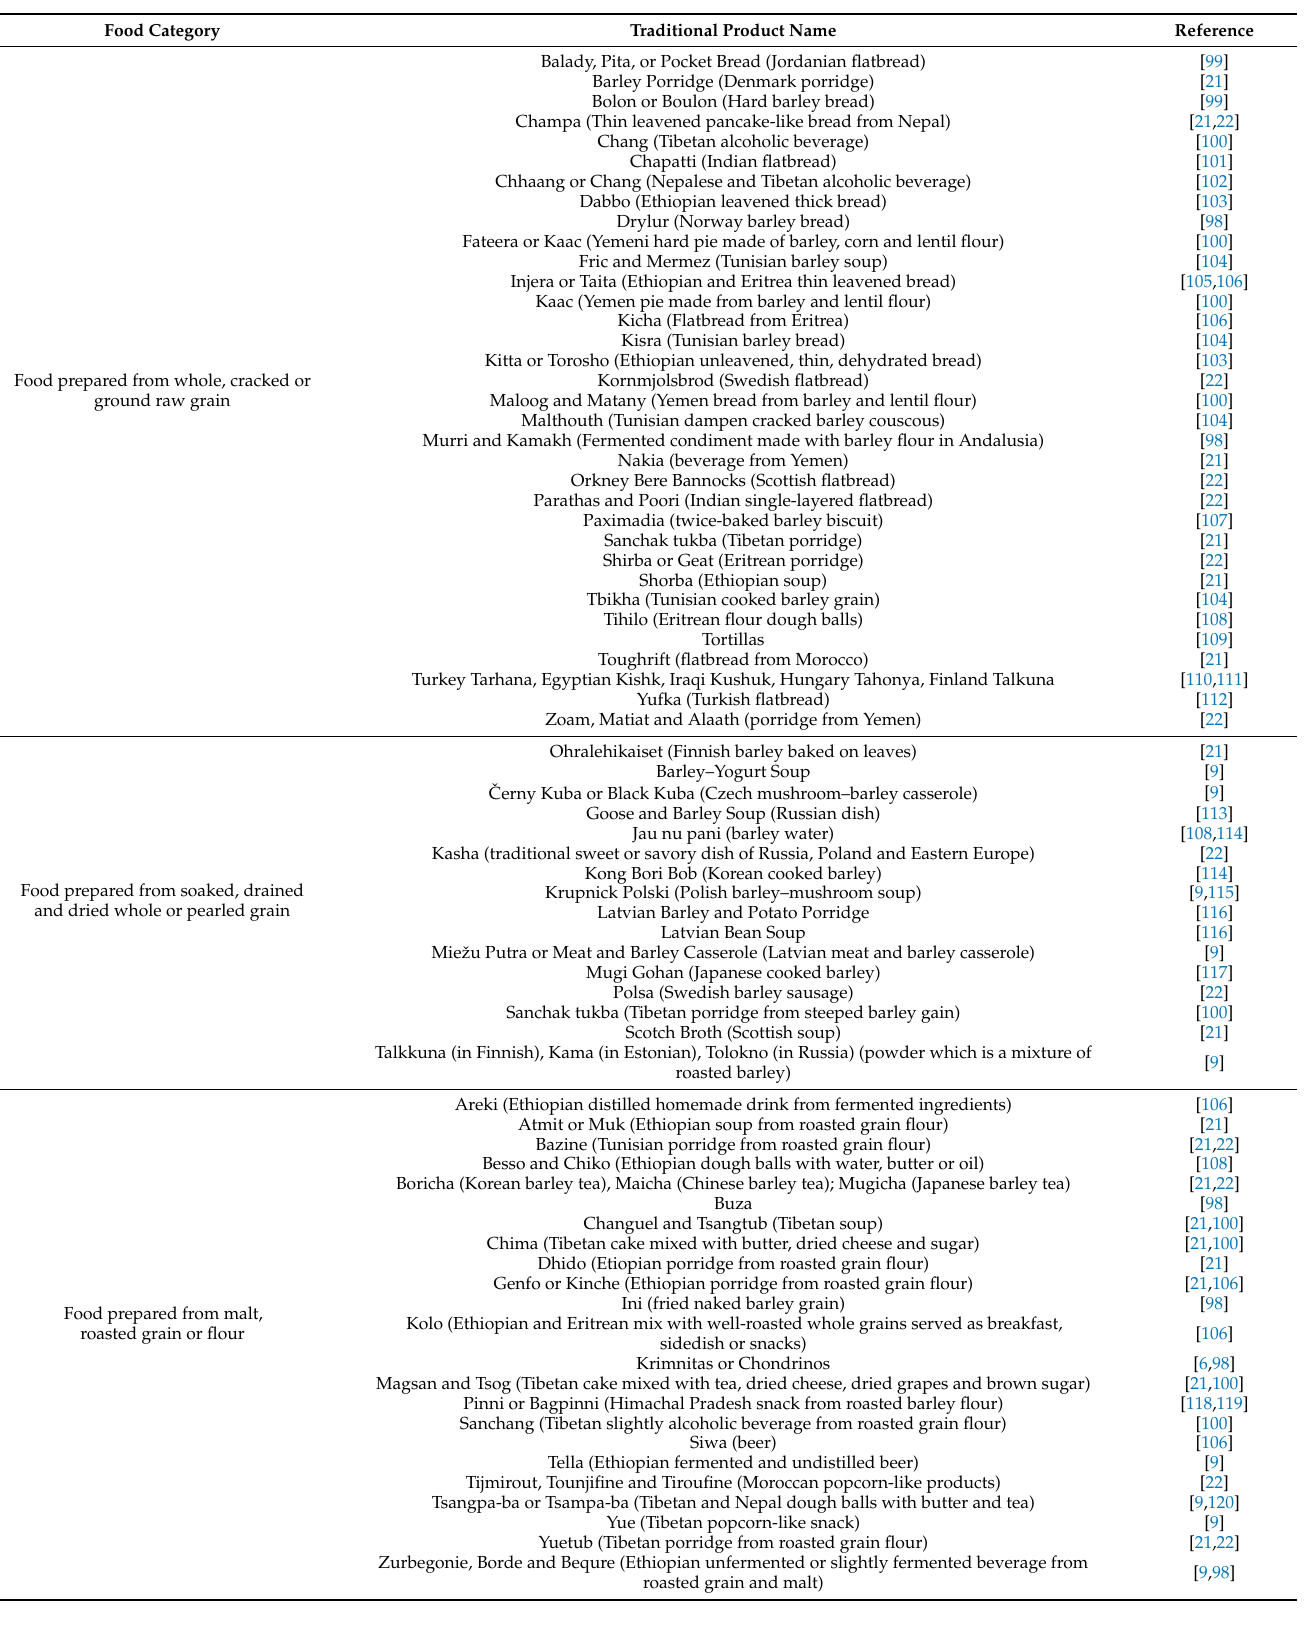
Table 4. Barley-based traditional food prepared from whole, cracked or ground raw